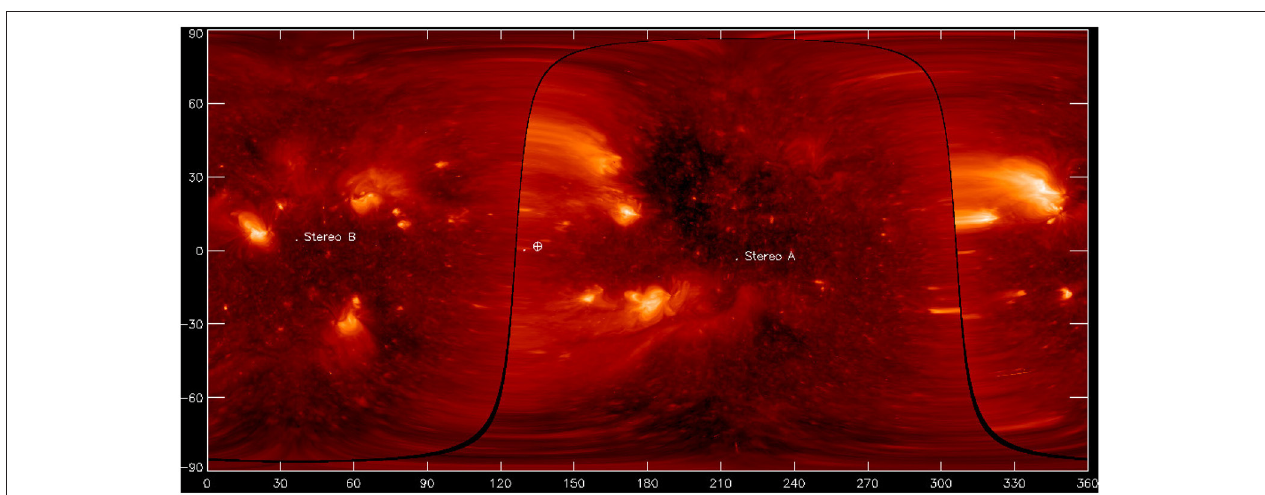
FIGURE 2 | A Carrington map of EUV synchronic observations of the full 360 ◦ sun, made possible by far-side imaging provided by the twin STEREO spacecraft. Images were taken in the 284 Å channel on February 6, 2011 at 18:00 UT while the STEREO spacecraft were in exact